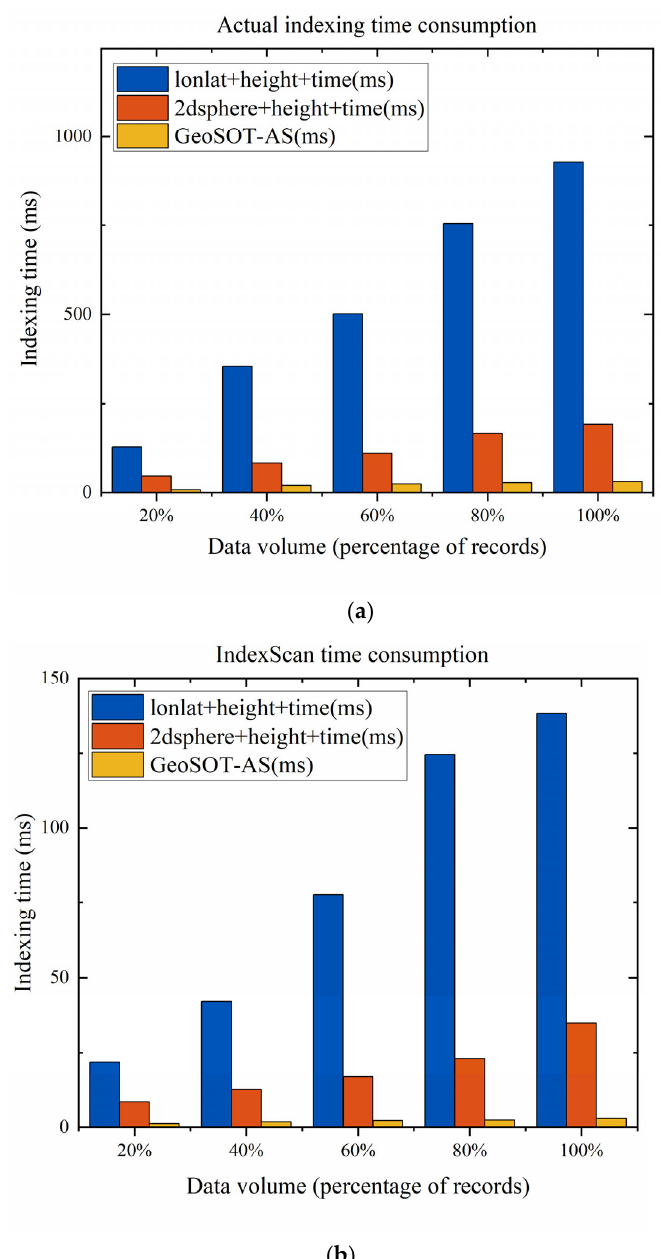
Figure 11. Comparison of time spent on the spatiotemporal range indexing for a fixed time: ( a ) actual time consumption for the indexing operation; ( b ) time consumption for the Index Scan process.